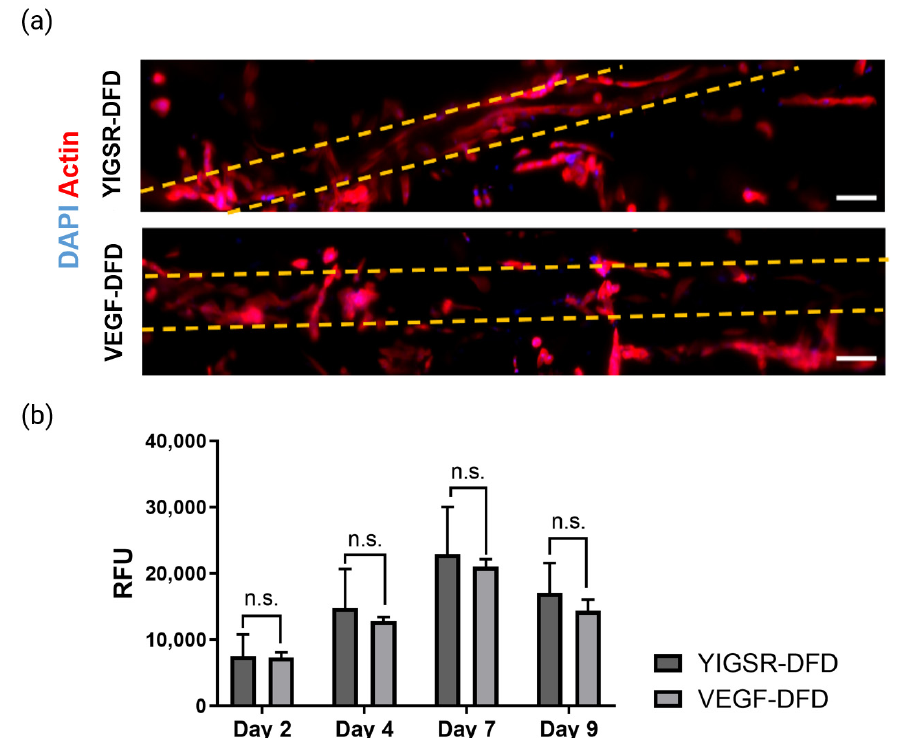
Figure 6. Cell analysis of seeded HUVECs on scaffolds functionalized with Caf1 ‐ YIGSR and Caf1 ‐ VEGF via the DFD method. ( a ) Tile ‐ scan images represent Z ‐ Projections (average intensity) showing cell morphology inside the scaffold channel (full length) at day 7 via CLSM. Scale bar = 100 μ m. Yellow dashed lines represent the limit of the microchannel; ( b ) Cell metabolic activity of seeded HUVECs determined by resazurin assay on days 2, 4, 7, and 9. Statistical analysis was performed using a two ‐ way ANOVA.